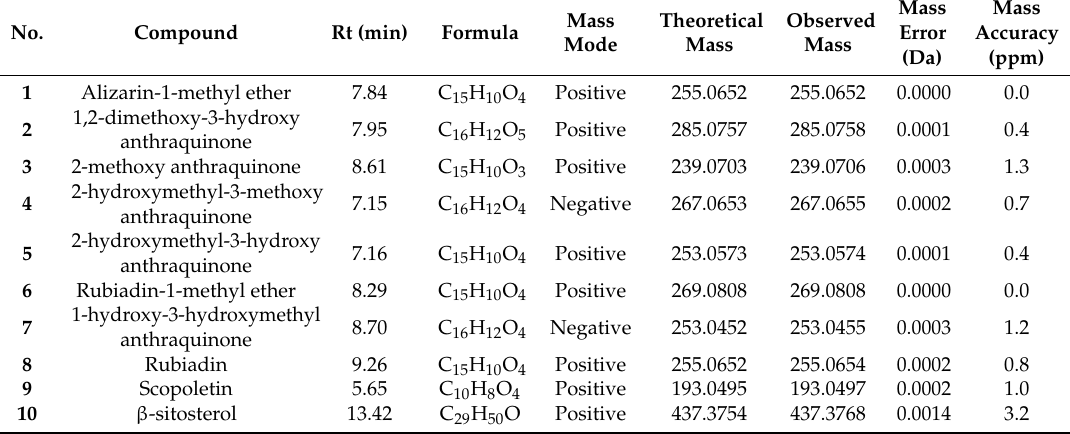
Table 1. Identification of compounds 1 – 10 in M. officinalis by UHPLC-ESI/LTQ-Orbitrap-HRMS analysis.